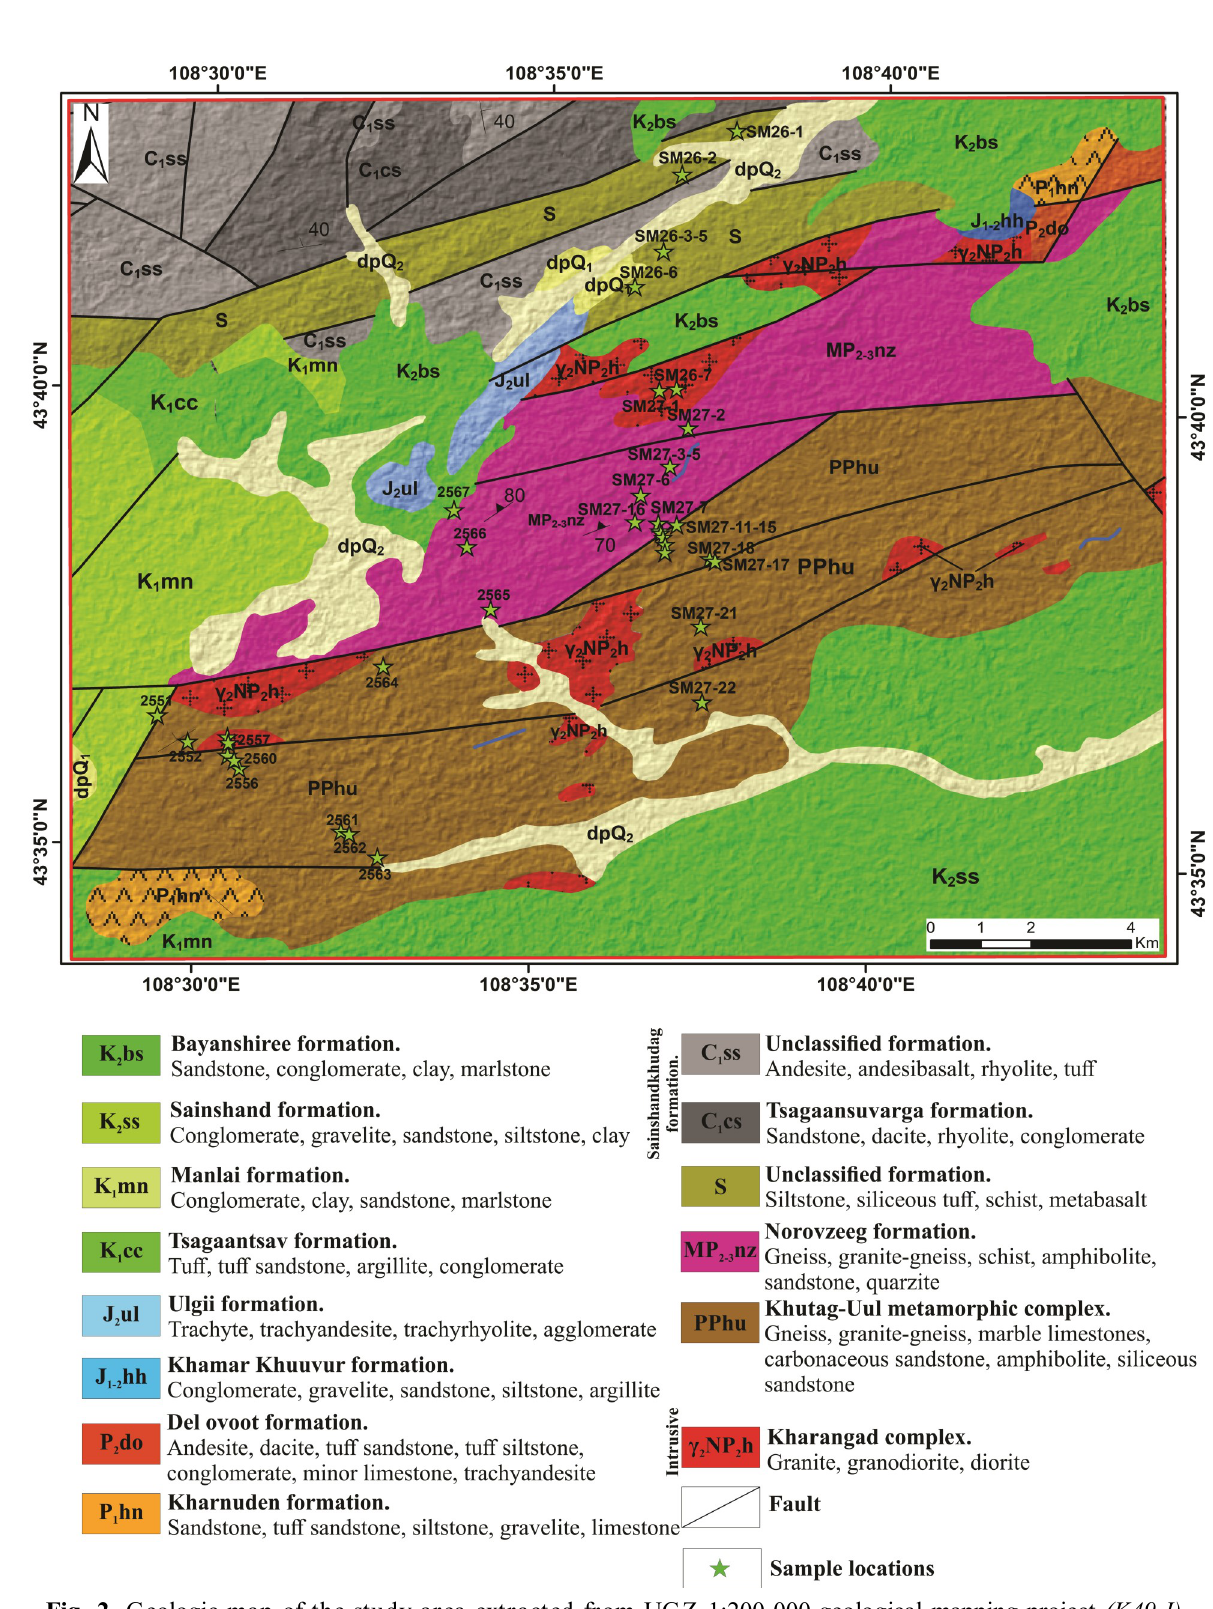
Fig. 2. Geologic map of the study area extracted from UGZ 1:200 000 geological mapping project (K49-I) (Bumburuu et al.,